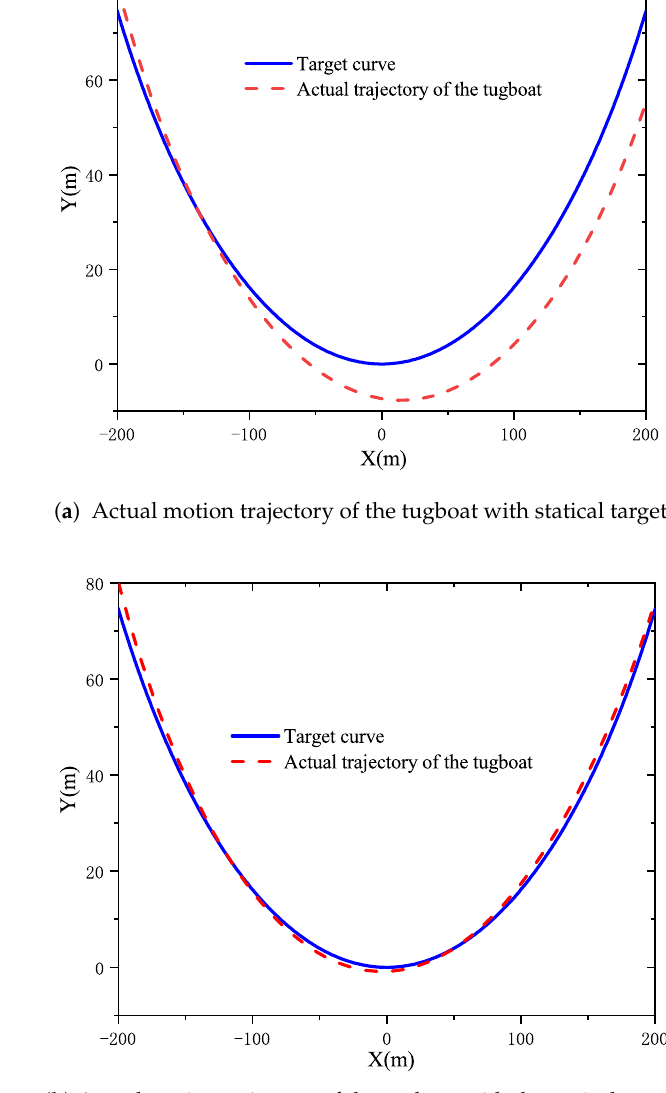
Figure 4. Actual motion trajectory curve of the tugboat by using different speed